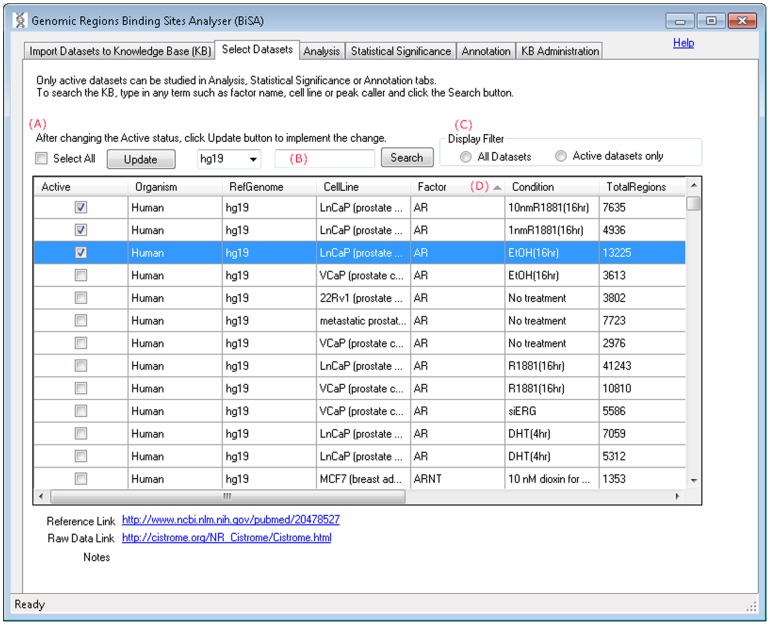
Select Datasets.This tab displays a list of all datasets in the KB, populated by default or as a consequence of uploading in Step-1. Clicking on the text of any row displays the reference link of the article, raw data link and notes, if any, below the table. Website addresses are hyperlinked to the websites/articles from where the data are obtained. (A) Changing the Active ticks and clicking on the Update button implements the selection. (B) Users can search the KB by organism, cell line, factor label, reference genome or peak caller.